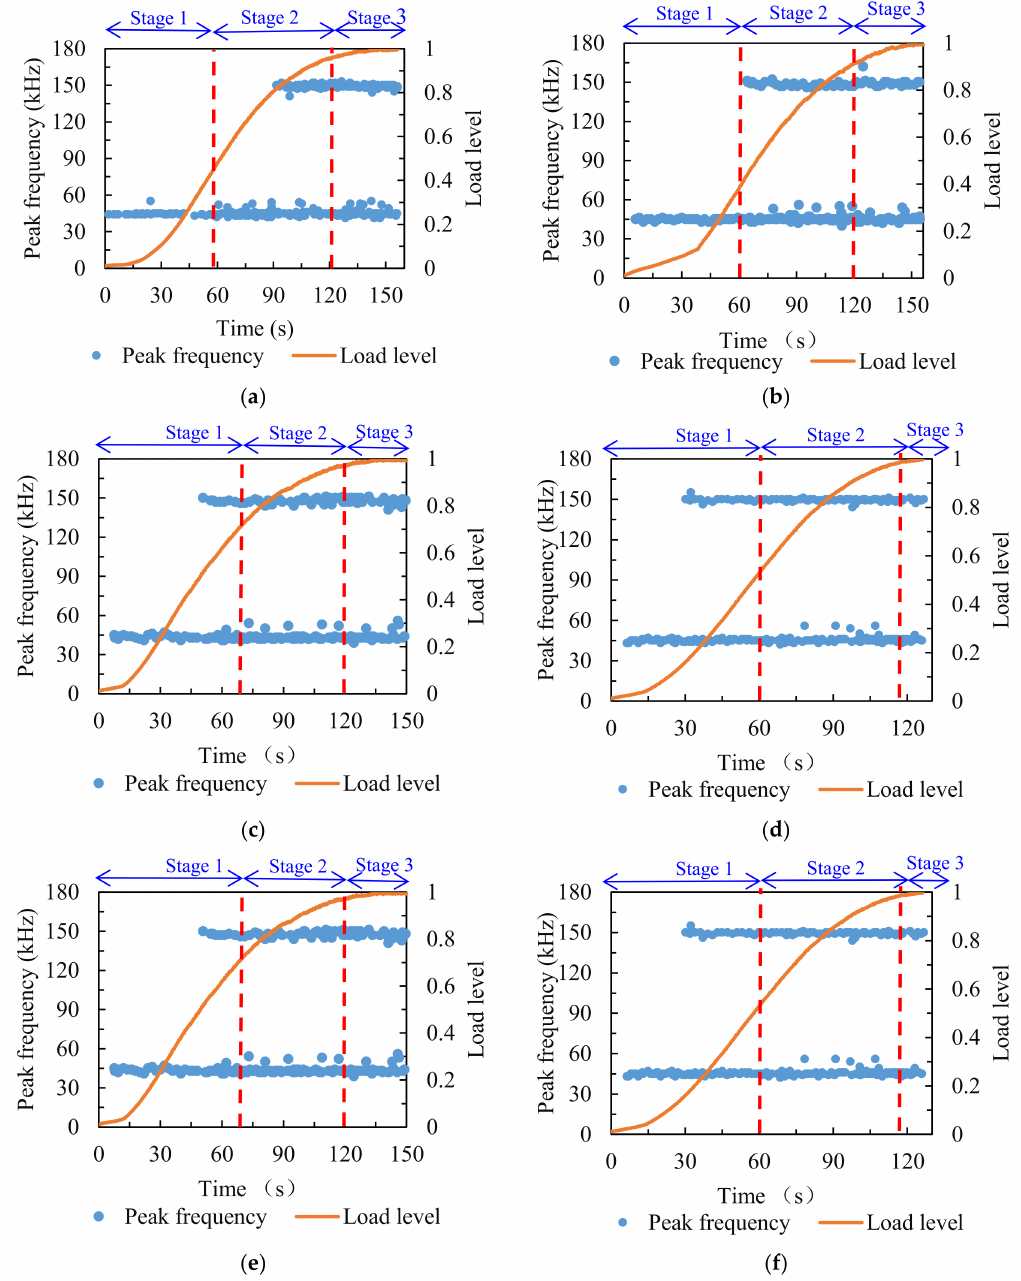
Figure 11. Peak frequency distribution of specimens treated with various aging conditions: ( a ) 0 h; ( b ) STA; ( c ) LTA of 24 h; ( d ) LTA of 72 h; ( e ) LTA of 20 h; ( f ) LTA of 168